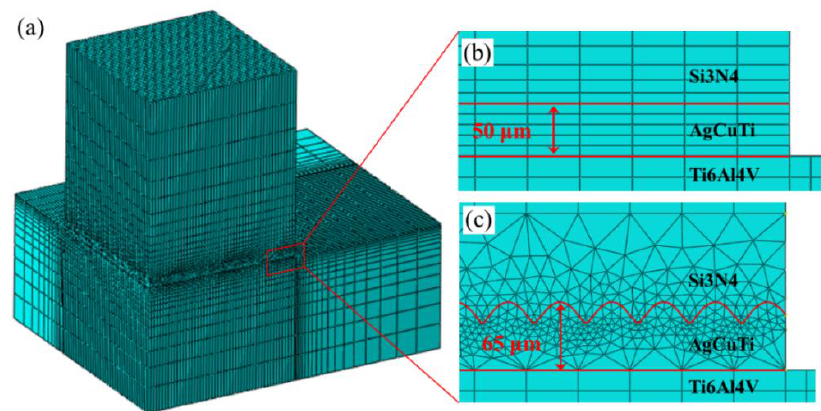
Figure 10. ( a ) Si 3 N 4 –titanium alloy joint model, ( b ) pristine surface, and ( c ) dense surface of the brazed joint.